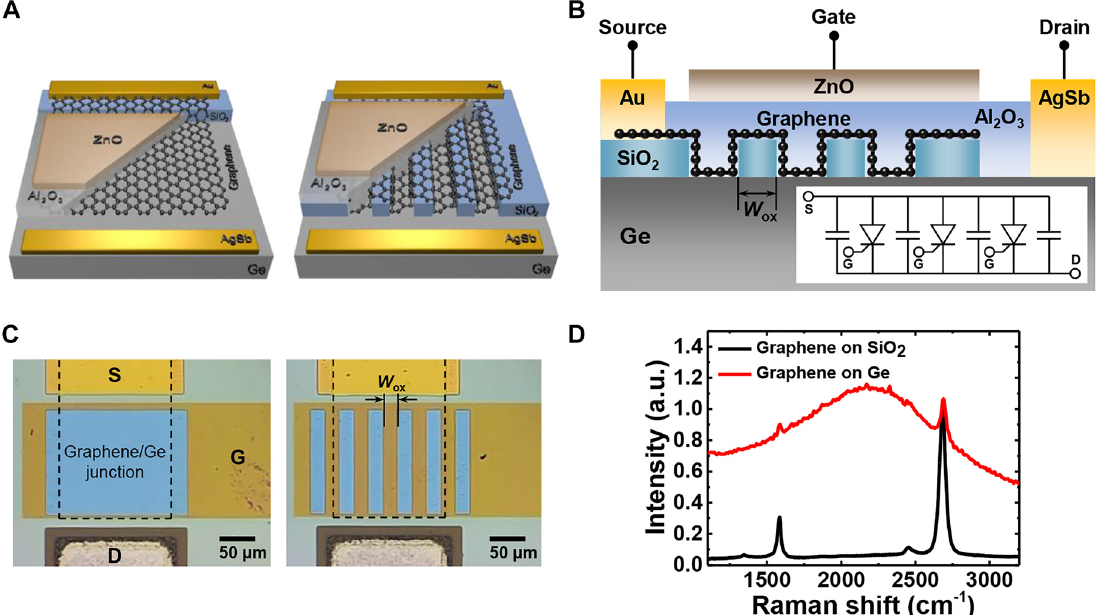
Figure 1: (A) Schematic diagrams of the single (left) and split (right) active junction structure of the gate-controlled graphene/Ge Schottky junction photodetector. (B) Cross-sectional schematic of a split active junction device. W ox represents the width of the interdigitated oxide layer,andfourdevices( W ox =0,10,20,or30 μ m)werefabricated.Inset:equivalentcircuit,wherethecapacitorsareconnectedinparallelwith the gate-controlled Schottky diodes. (C) Optical images of fabricated single (left) and split (right) active junction devices. Black dashed rectangle: graphene area. (D) Raman spectrum of monolayer graphene on SiO 2 and Ge